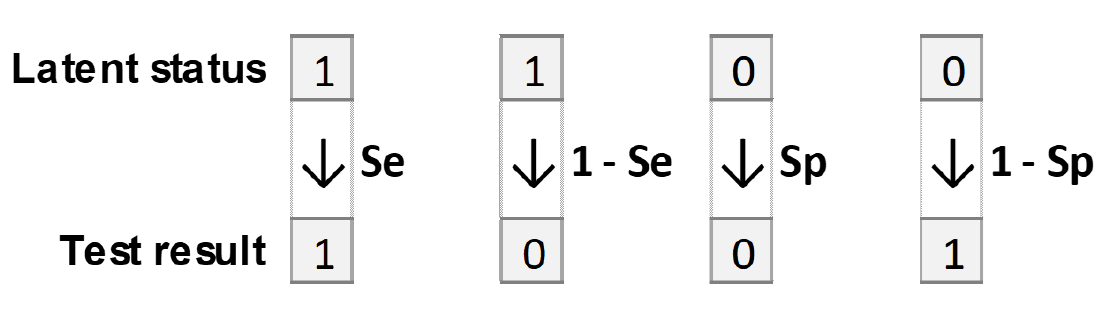
Figure 3 – Relation of the model latent status to test result. Sensitivity is the probability of a positive test result in a status positive herd. Specificity is the probability of a negative test result in a status negative